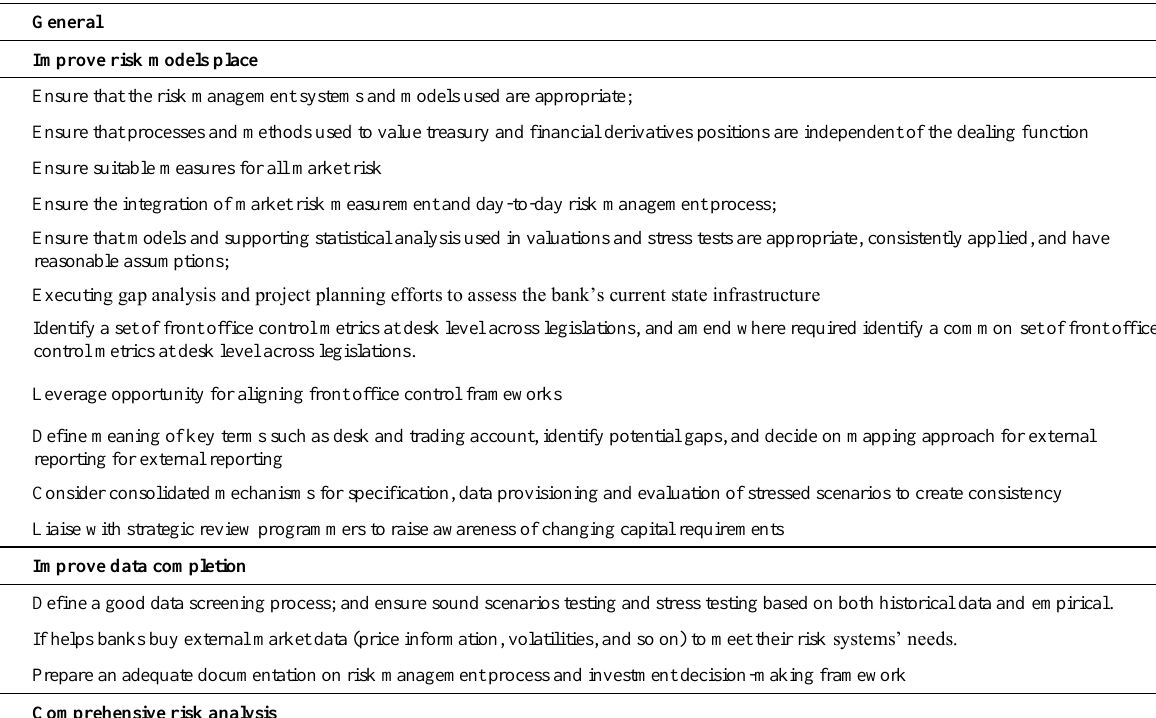
Table 4. Checklist for the implementation of